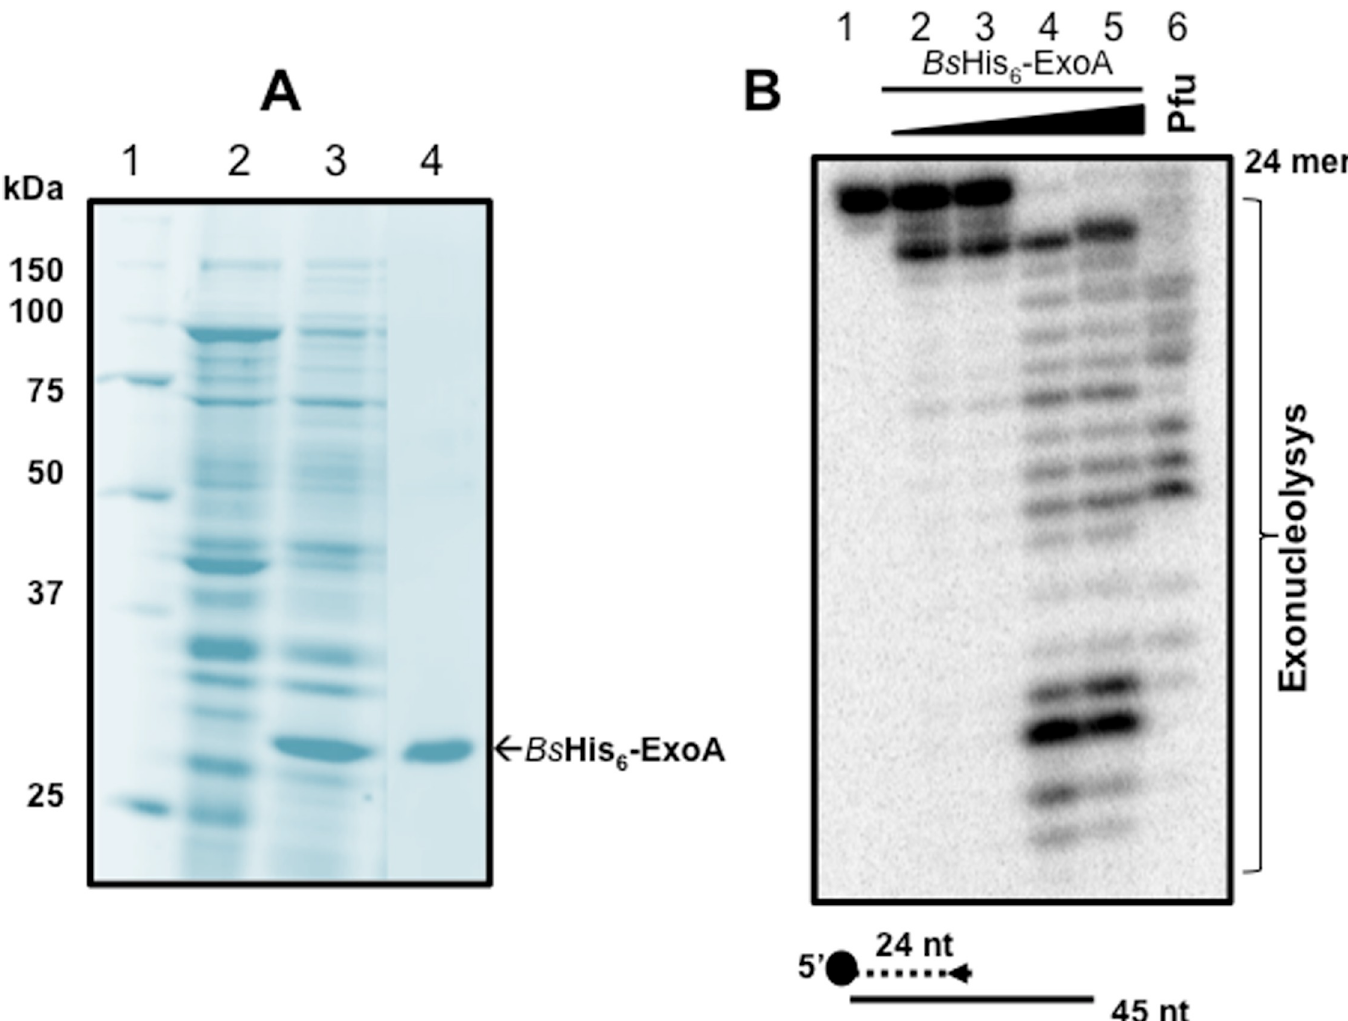
Fig 5. Purification and 3’ ➔ 5’ exonuclease activity of Bs ExoA. (A) SDS-PAGE analysis of His 6 - Bs ExoA induction and purification by IMAC as described in Methods. Lane 1, molecular weight markers; lane 2, cell lysate of non-induced E . coli PERM1311 strain; lane 3, IPTG-induced extract of E . coli PERM1311; and lane 4, protein eluted from the Ni-NTA column with 300 mM imidazole. (B) 3’ ➔ 5’ exonuclease activity of Bs ExoA. Nuclease reactions were conducted with 0, 1, 10, 100 or 1000 nM of Bs ExoA (lanes 1–5) with a radiolabeled 24-mer-oligonucleotide hybridized with a non-radioactive 45-mer-oligonucleotide and incubated at 37˚C as described in Methods. A positive control for DNA degradation was carried out with Pfu Pol I without dNTPs (lane 6). All reactions were separated by denaturing electrophoresis, exposed and analyzed as describe in Methods.